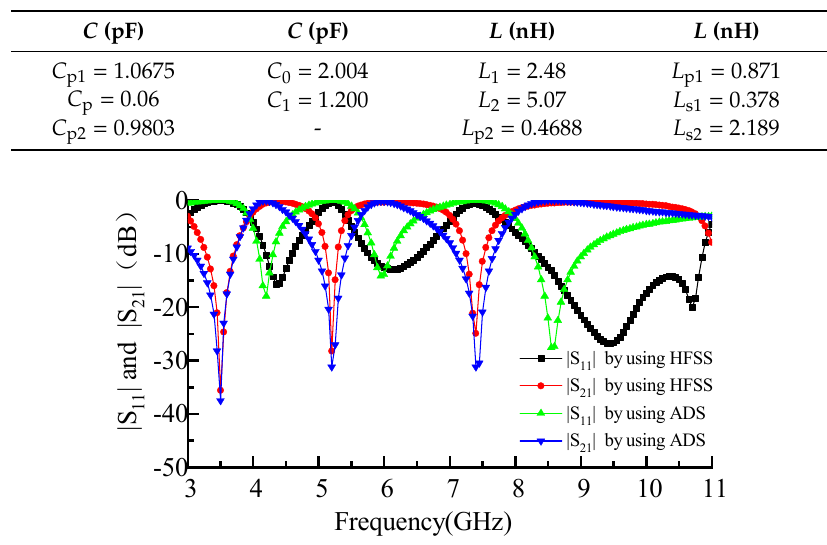
Figure 13. The comparison of simulation results by using HFSS and ADS.